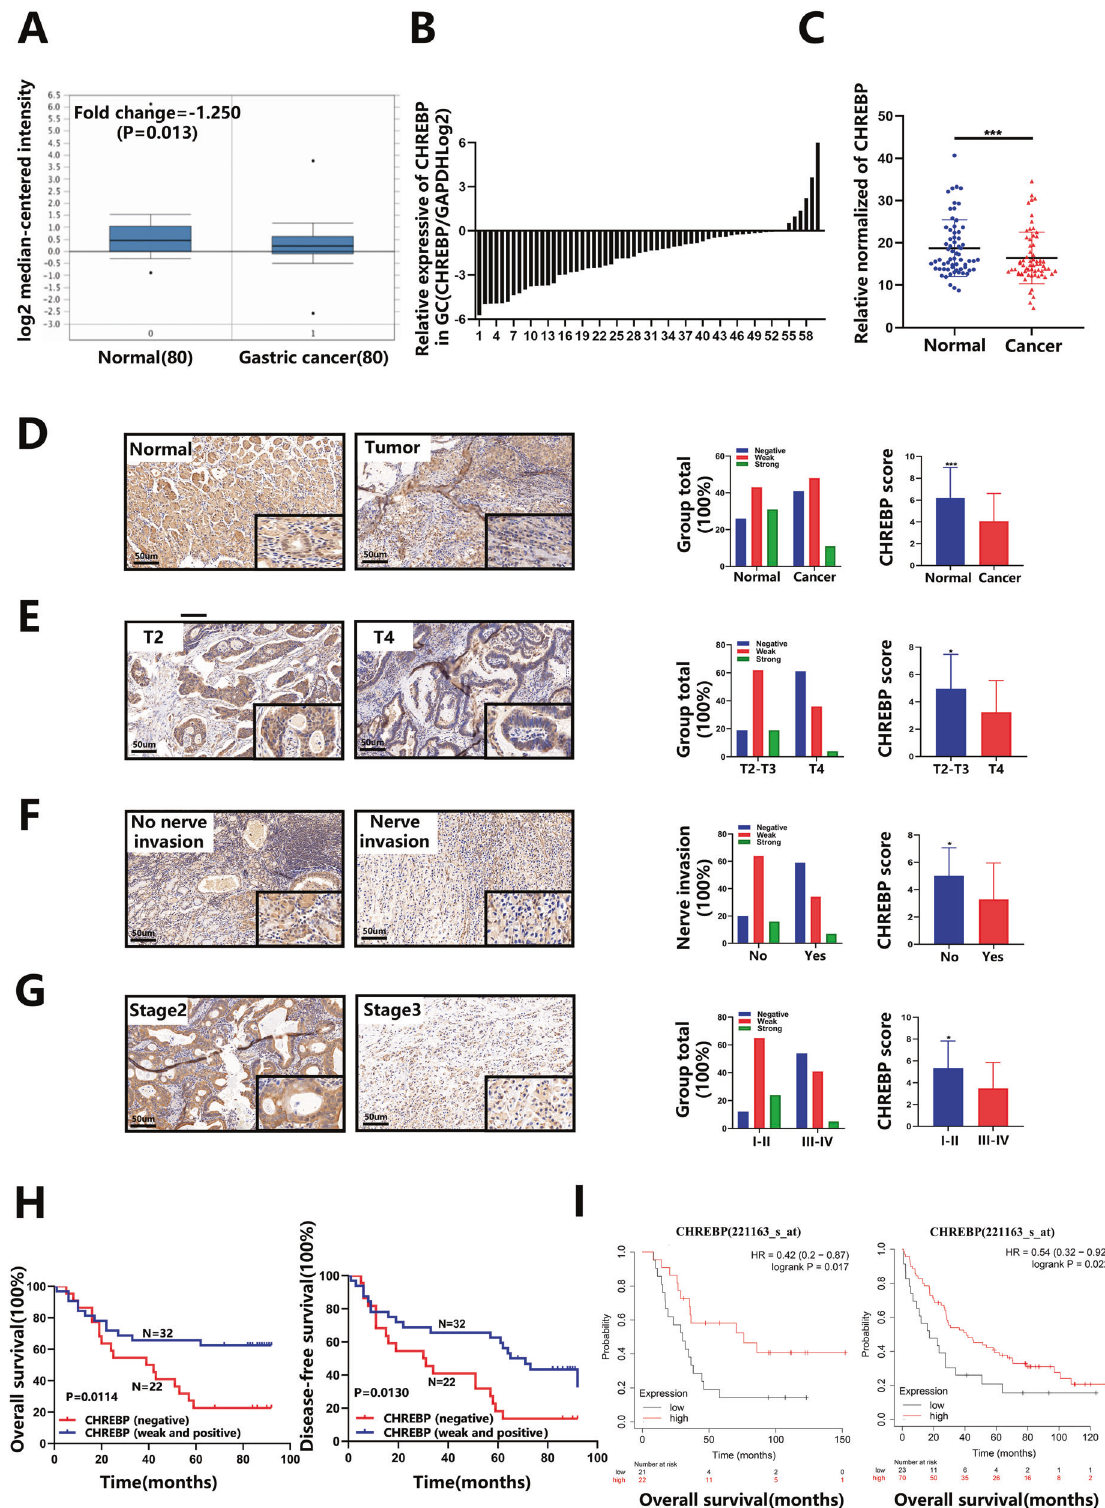
Fig. 1 The level of CHREBP is downregulated in GC tissues and is associated with a poor prognosis. A Data from the Oncomine database showed that the level of CHREBP was decreased in GC in contrast with normal samples. B , C CHREBP expression in 60 GC and surrounding normal samples was examined by qRT – PCR. CHREBP expression was lower in 48 (80.00%) GC samples. D Representative pictures of CHREBP expression in GC and surrounding normal samples (scale bar: 50 μ m) from TMAs. E – G Comparing the level of CHREBP between T2 and T3 vs. T4 ( E , P = 0.004), No nerve invasion vs. Nerve invasion ( F , P = 0.013), early TNM stage (stage I and II) vs. advanced TNM stage (stage III and IV) ( G , P = 0.005). H Patients with lower CHREBP expression had worse OS ( P = 0.0114) and DFS ( P = 0.0130). I The data (GSE22377, left panel) and (GSE51105, right panel) from Kaplan – Meier plotter revealed that patients with decreased CHREBP expression had a shorter OS ( P < 0.05).